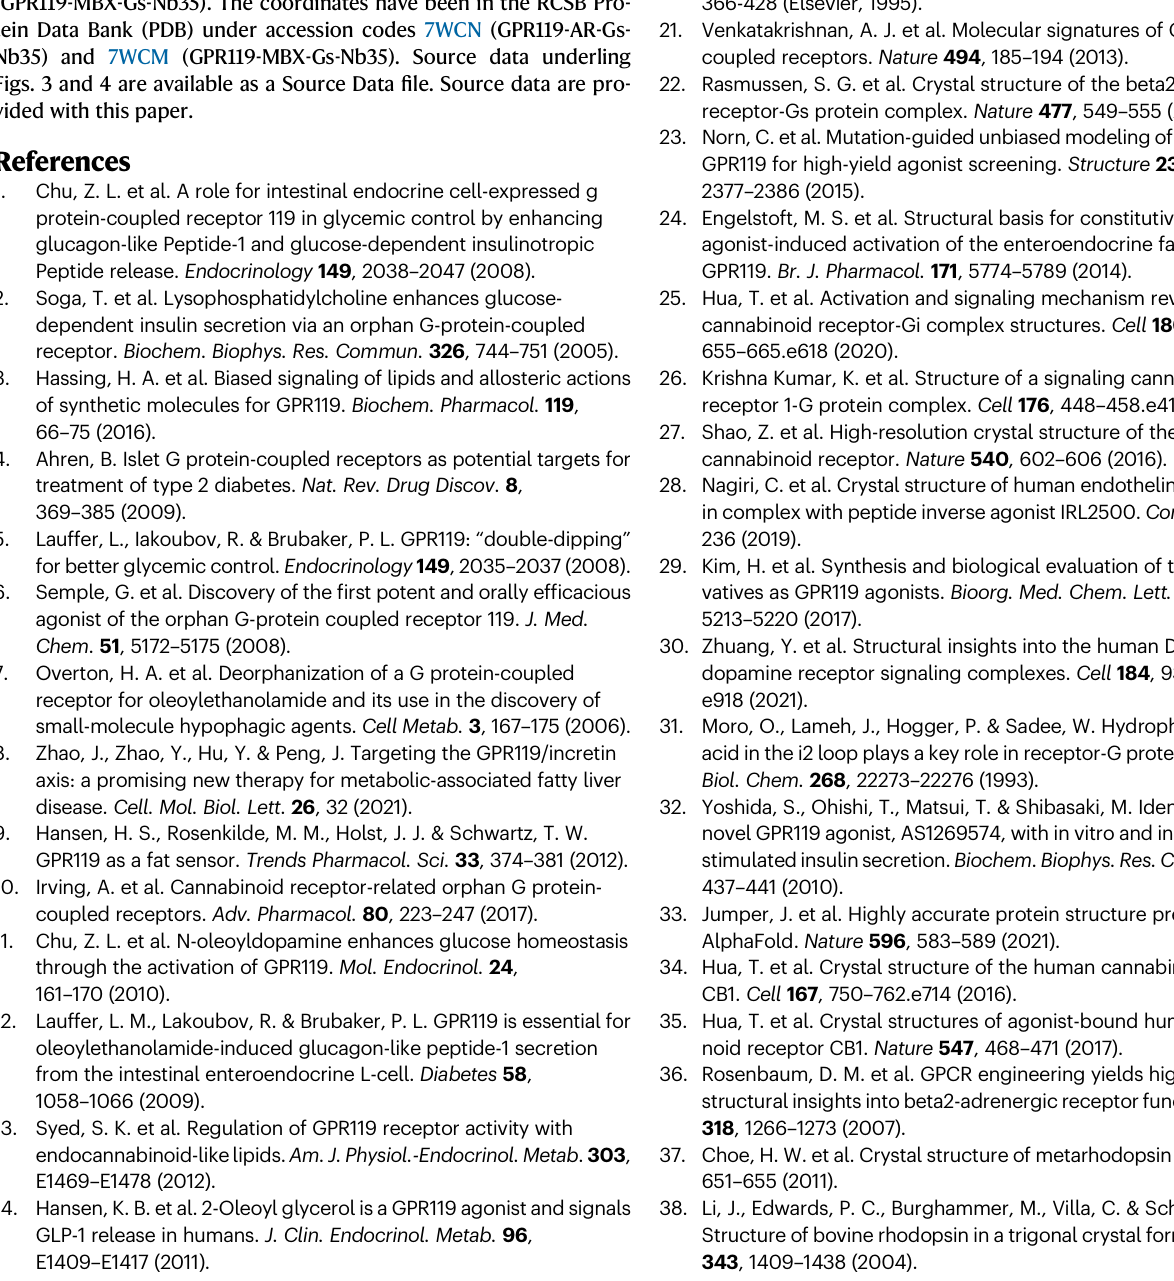
Figs. 3 and 4 are available as a Source Data fi le. Source data are pro- vided with this